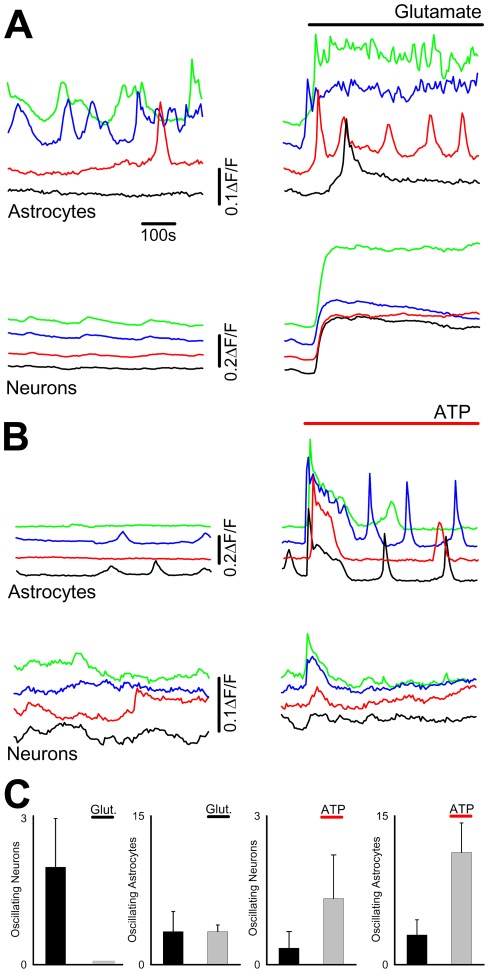
Sustained transmitter exposure in eliciting calcium oscillations.
A. Fluorescence time courses from astrocytes and neurons in the same experiment before (left panels), and following (right panels) sustained application of glutamate. Activity in the same cell is indicated by colour. B. Activity in astrocytes and neurones before (left panels) and following (right panels) application of ATP. C. Bargraphs summarising results from a number of experiments illustrating the effect of sustained glutamate and ATP application on the number of astrocytes and neurons expressing calcium oscillations. Cells were used within 14 days of differentiation.